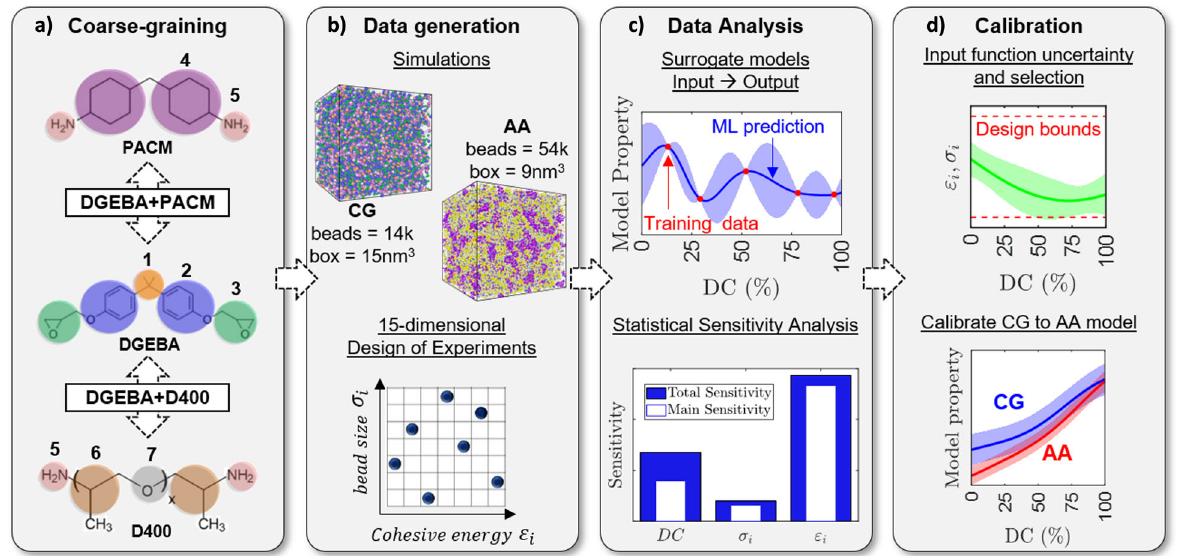
Fig. 1 Flowchart of the coarse-graining parametrization protocol. a Mapping of the CG beads onto the AA chemical structure for DGEBA, PACM, and D400. b Generation of the training set of CG simulations varying the non-bonded parameters in a 15-dimensional space (two parameters per bead, plus the degree of crosslinking) and generating corresponding system responses. c Construction of the Gaussian process models from the training set to predict the macroscopic response of the AA simulations for given non-bonded parameters, and sensitivity analysis of each parameter. d Determination of the optimal values of the CG non-bonded parameters at each DC to match the target properties of the AA